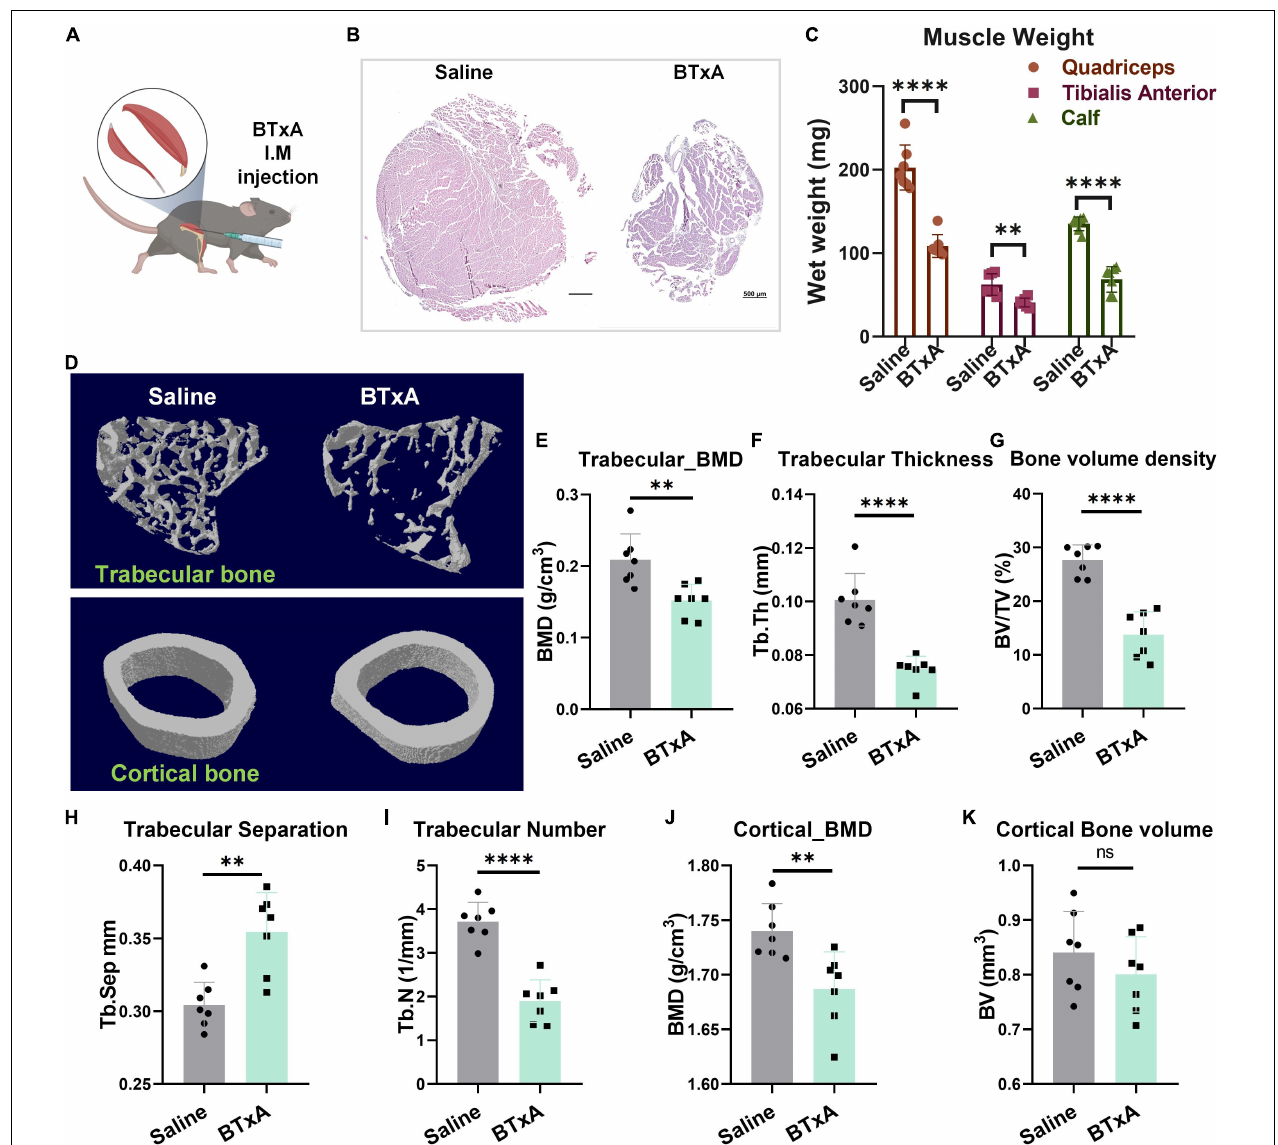
FIGURE 1 | Mechanical role of muscle serves to maintain bone homeostasis. (A) BTxA induced muscle-derived force deprivation murine model. (B) Left, quadriceps of saline-injected mice; right, quadriceps of BTxA-injected mice. Scale bar, 500 µ m. (C) Hindlimb muscle mass of quadriceps and calf and tibialis anterior muscles in saline- and BTxA-injected mice. (D) Quantitative analysis of representative µ CT images of trabecular and cortical bones. (E–l) Effect of muscle-derived force on bone parameters; (E) trabecular BMD; (F) trabecular thickness; (G) trabecular volume fraction; (H) trabecular separation; (I) trabecular number; (J) cortical BMD; and (K) cortical bone volume. N = 7 per group. All data represent as mean ± SD. ∗∗ P < 0.01, ∗∗∗∗ P < 0.0001, ns means not significant. Student t- test for panels (C–K)